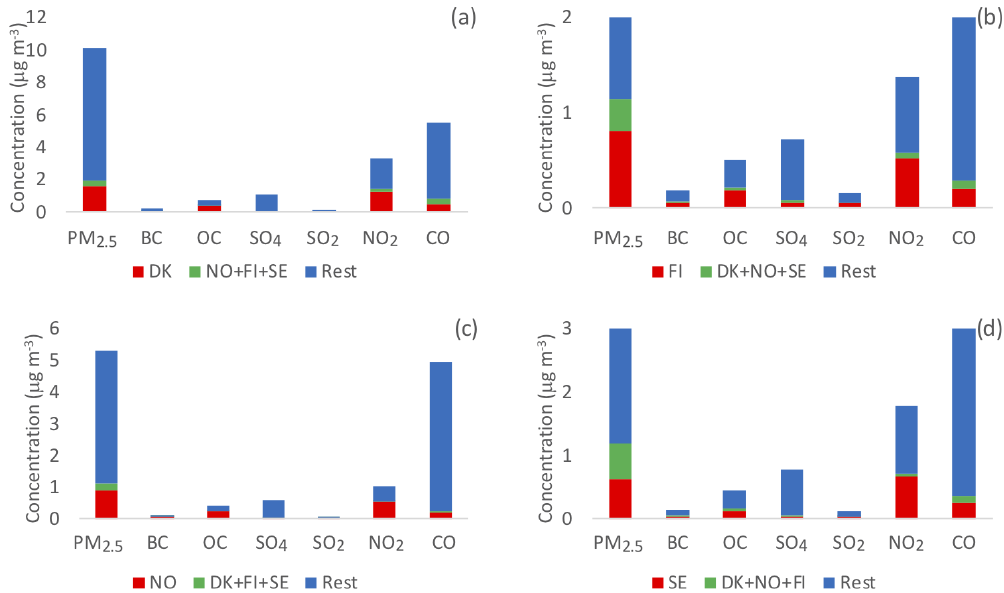
Figure 5. Absolute contributions of national, Scandinavian and other sources on the surface levels of major air pollutants over (a) Denmark, (b) Finland, (c) Norway and (d) Sweden. Note that CO concentrations are divided by 20 to scale with other